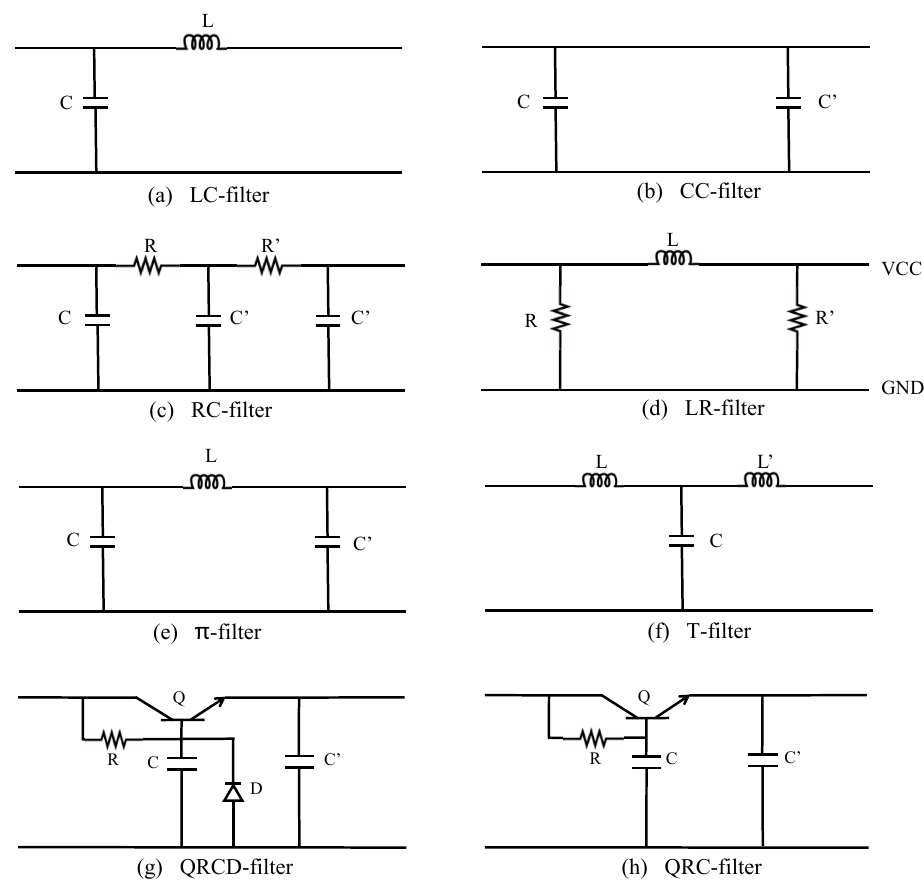
Figure 3. Eight different structures of